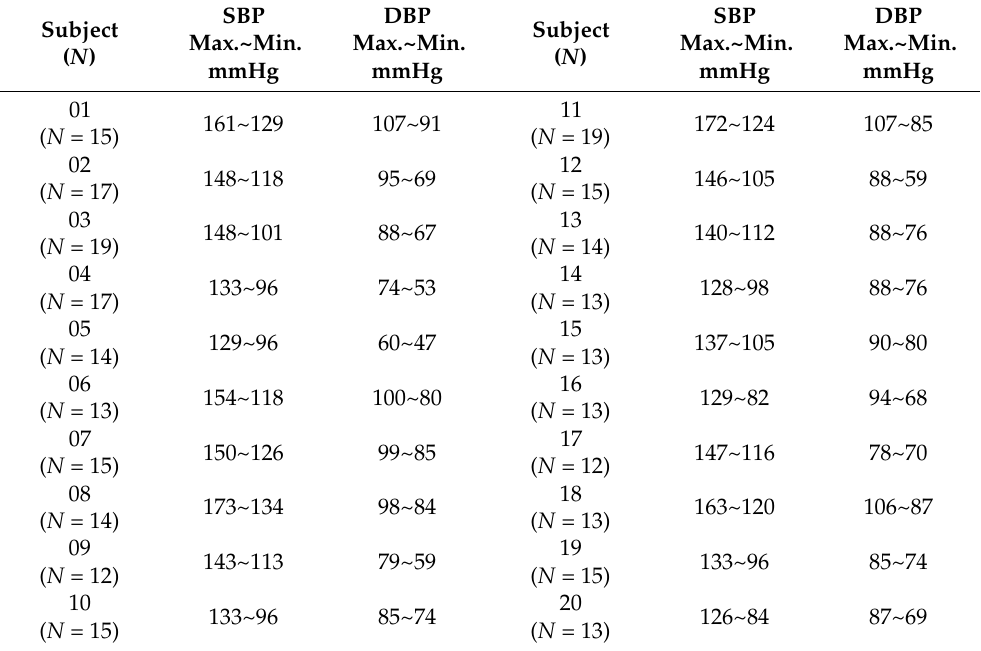
Table 1. Maximum and minimum ground-truth systolic and diastolic BPs and number of useful segments for all subjects in this